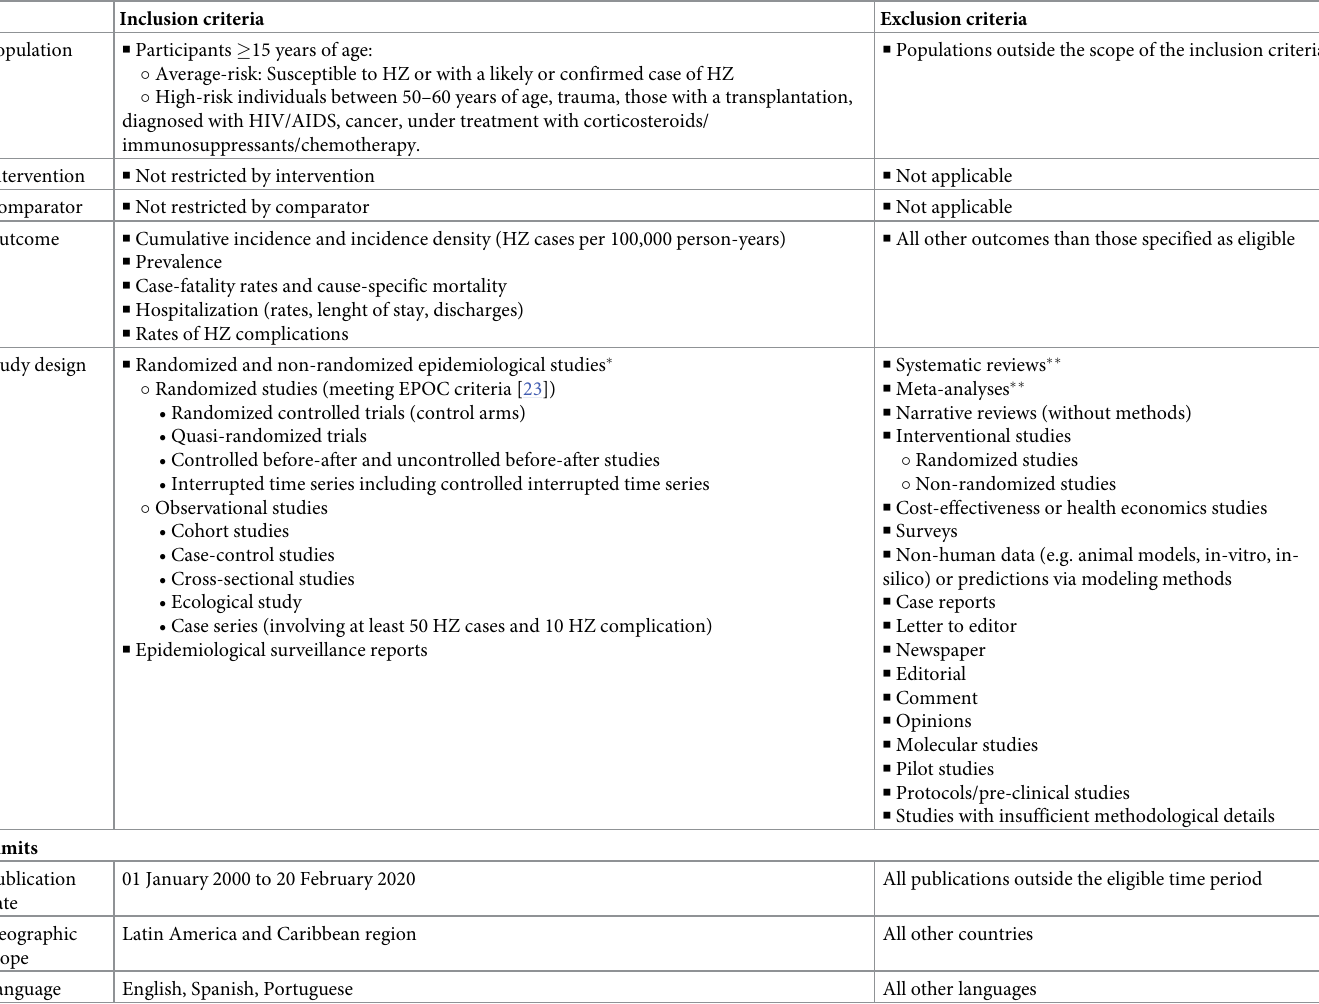
Table 1. Inclusion and exclusion